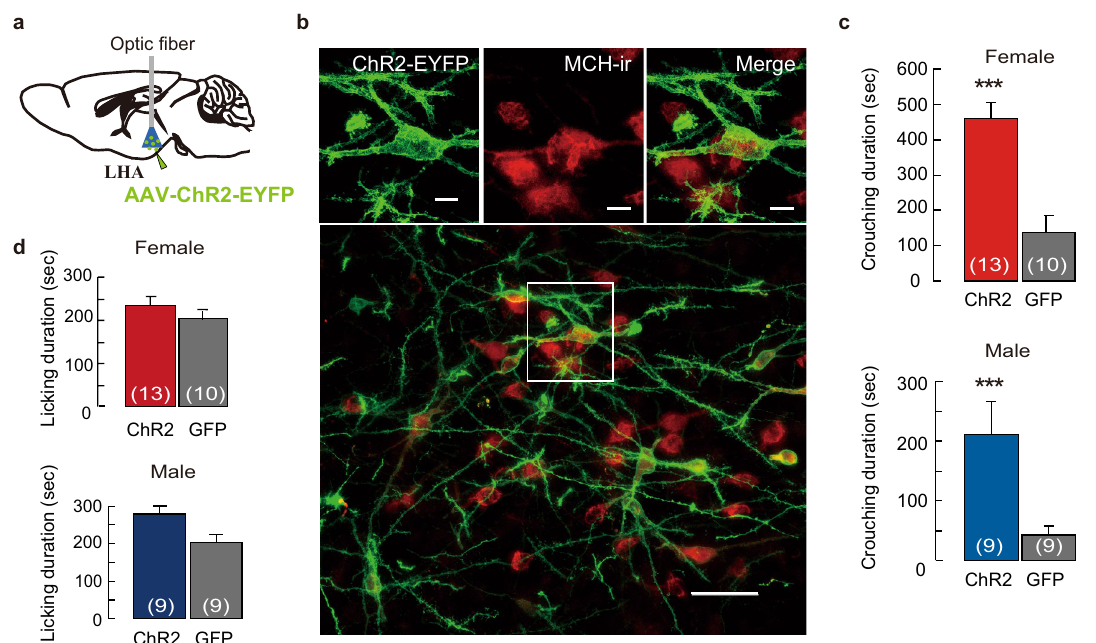
Figure 4. Optogenetic activation of MCH neurons prompts parental nursing behaviour in the LHA. ( a ) Illustration of sagittal brain sections injected with AAV-EF1a-DIO-hChR2 (E123T/T159C)-EYFP (ChR2-EYFP) and optogenetic stimulation in the LHA. ( b ) Co-labelled MCH-ir (red) and ChR2-EYFP (green) cells in the LHA. Scale bars are 10 µm in the above and 50 µm in the bottom; a square indicates place of above figures in the bottom. LHA-MCH neurons expressed ChR2-EYFP with considerable frequency. ( c ) Crouching and ( d ) licking duration of optogenetic stimulation in the LHA. Mean ± S.E.M. t-test, *** p <